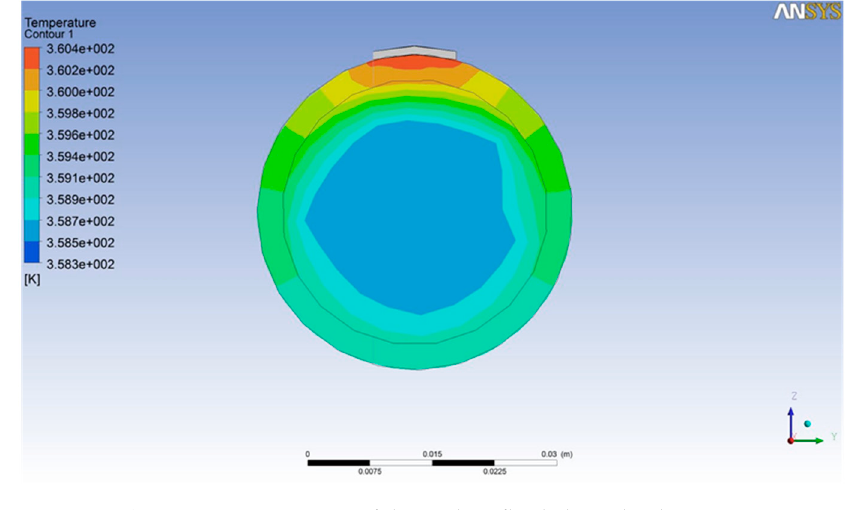
Figure 12. Temperature of the cooling fluid along the diameter.